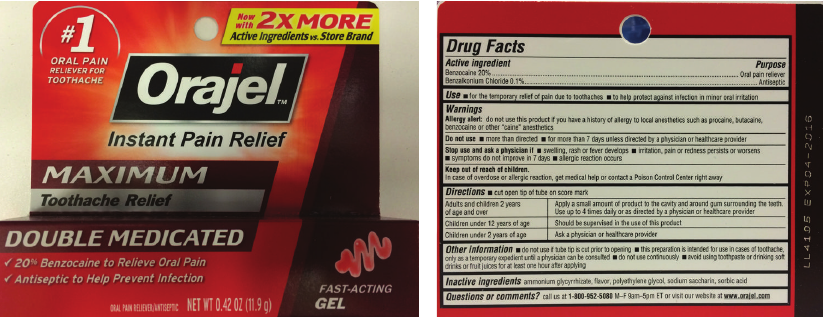
Figure 1: Orajel with ingredients including benzocaine 20%.